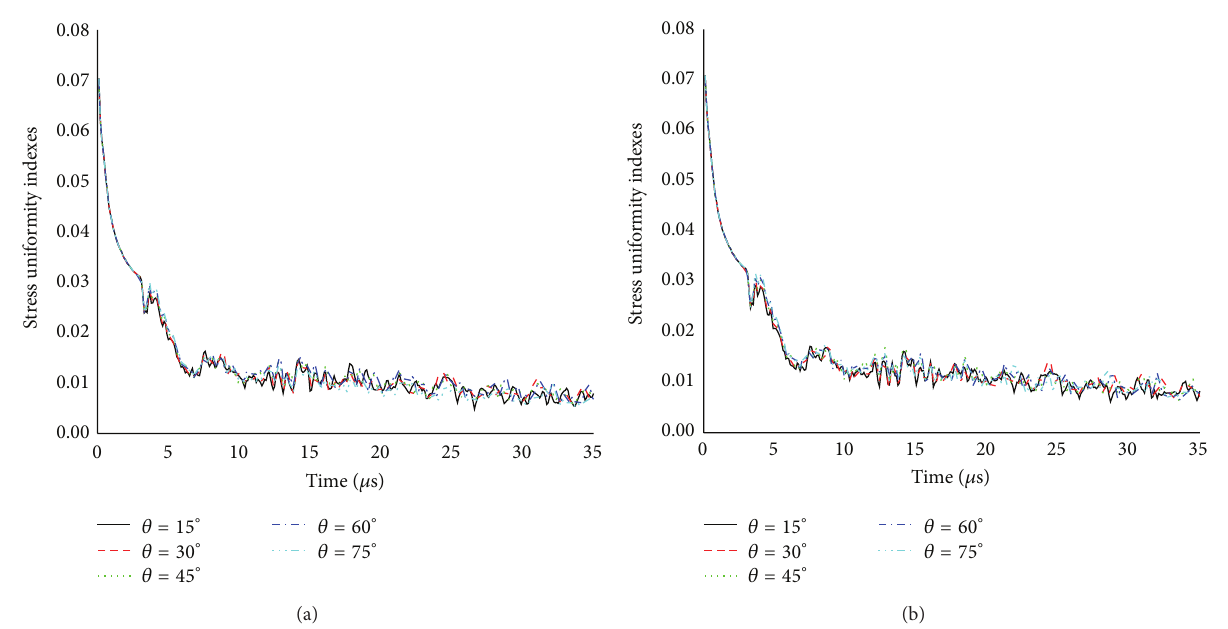
Figure 8: The influences of collagen fiber orientation on the SUI of L-bone for two orthotropic models: (a) model B and (b) model